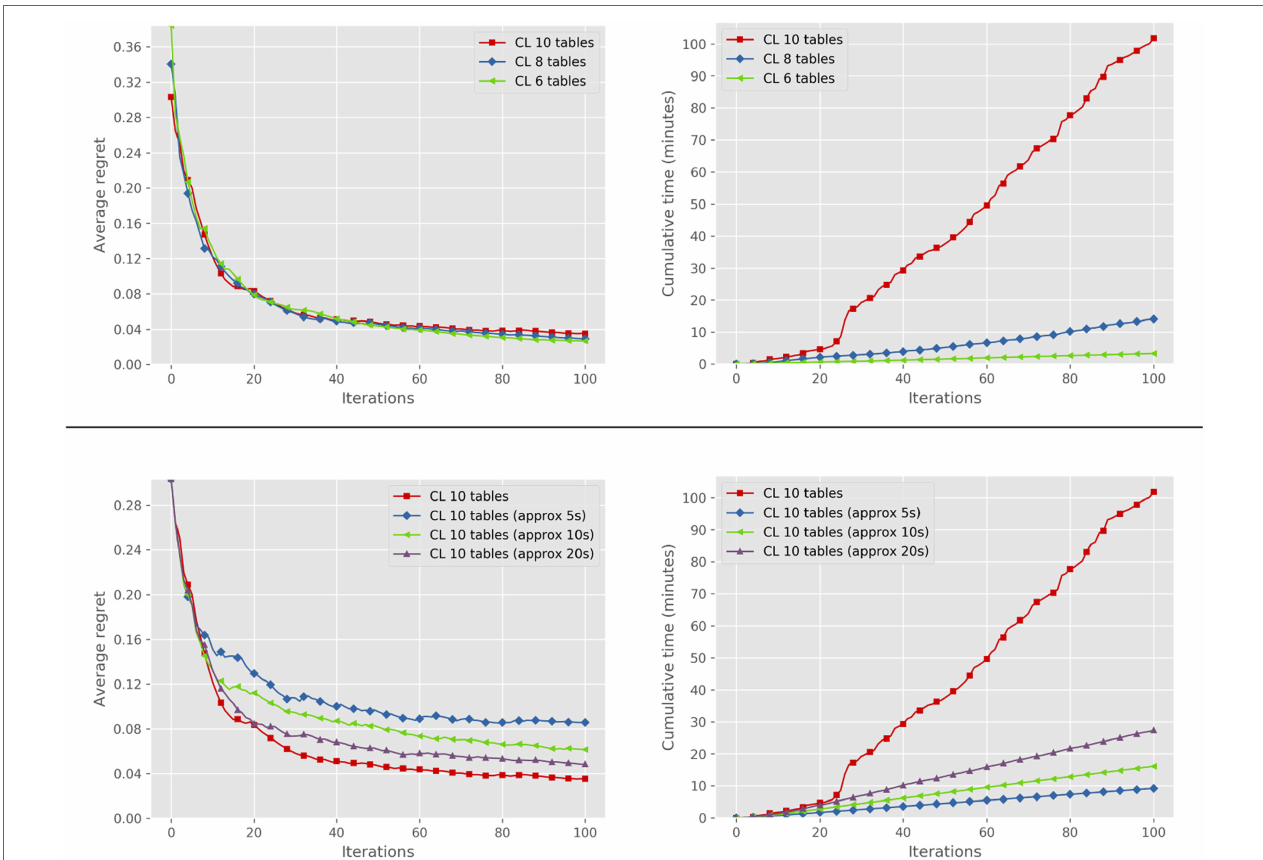
FIGURE 5 | Comparison of median average regret (left) and median cumulative time (right) of the system in the furniture arrangement setting with exact inference on 6, 8, and 10 tables (top); exact and approximate inference on 10 tables (bottom). Best viewed in color.